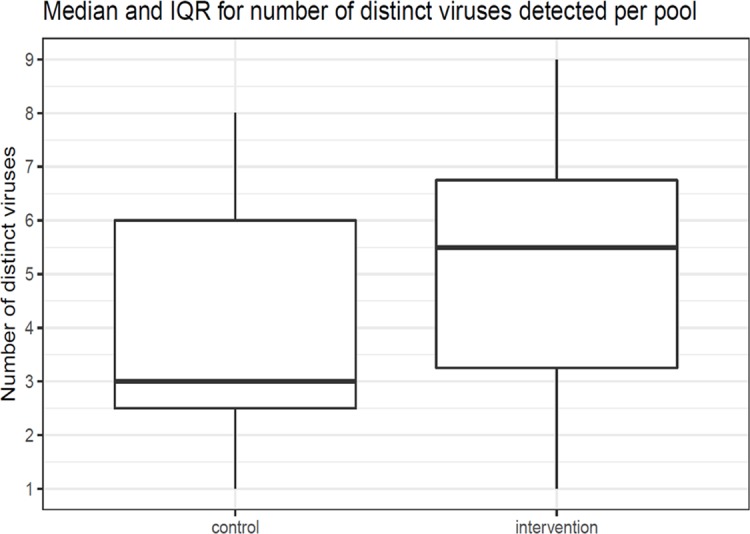
Median and IQR for number of distinct viruses detected per pool of the intervention and control groups.